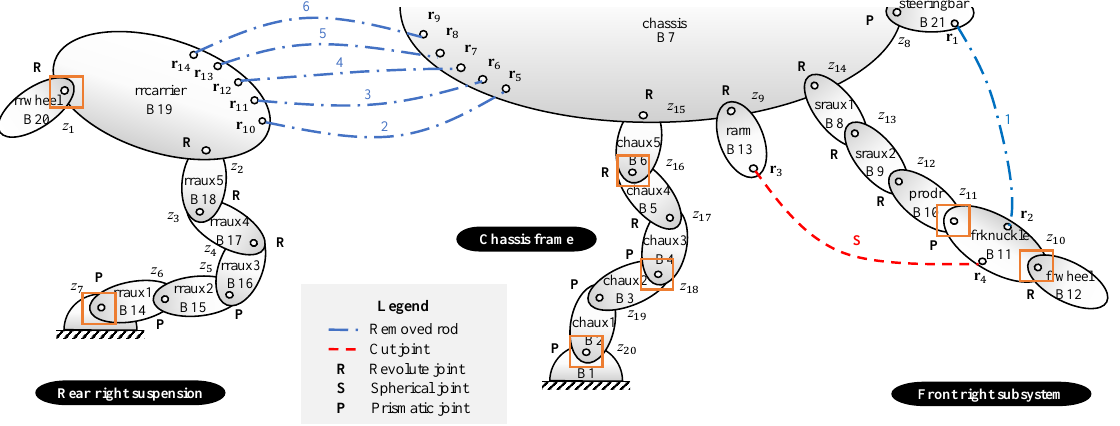
Figure 2. System structure of the 7-DOF vehicle system. To open the closed loops, the spherical joint connecting the steering knuckle and lower arm is cut, and three loop-closure constrained equations are generated. A steering tie rod and five rear suspension rigid rods are removed. The removed rods are represented by six equations constrained to a constant length. To formulate the dynamic equations of the vehicle system in an understandable way, the point s of body i that instantaneously coincides with the origin of the inertial reference frame is selected as the reference. The Cartesian velocities and accelerations of body i ( Z i and ˙ Z i ) and of the entire system ( Z and